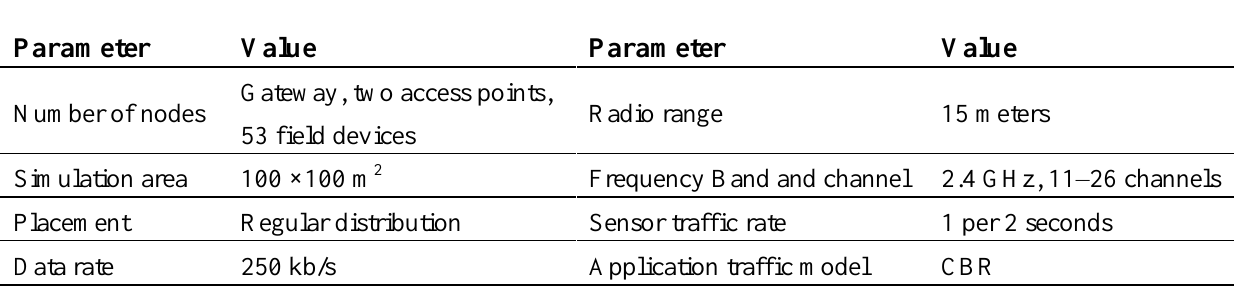
Table 3. NS-2 simulation